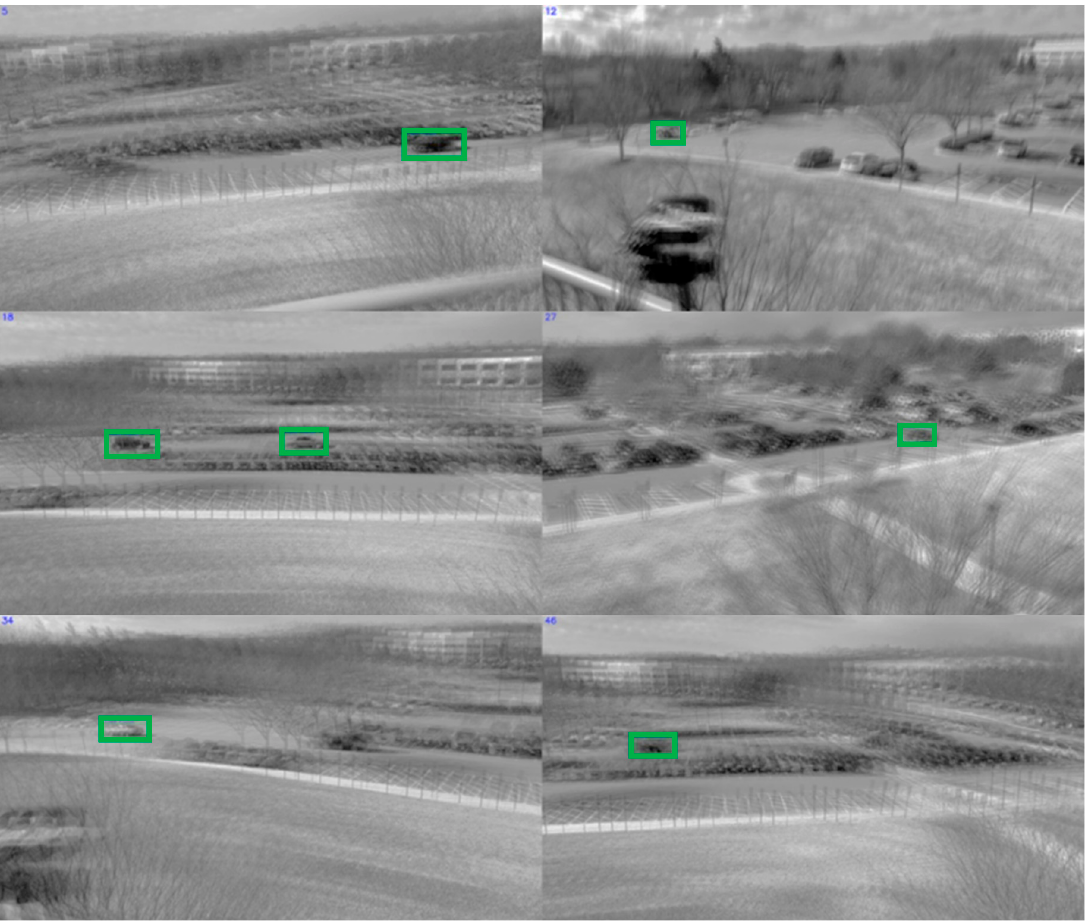
Figure A3. IMG430 with 0 percent missing, tiled image results. Bounding box detections outlined in green.